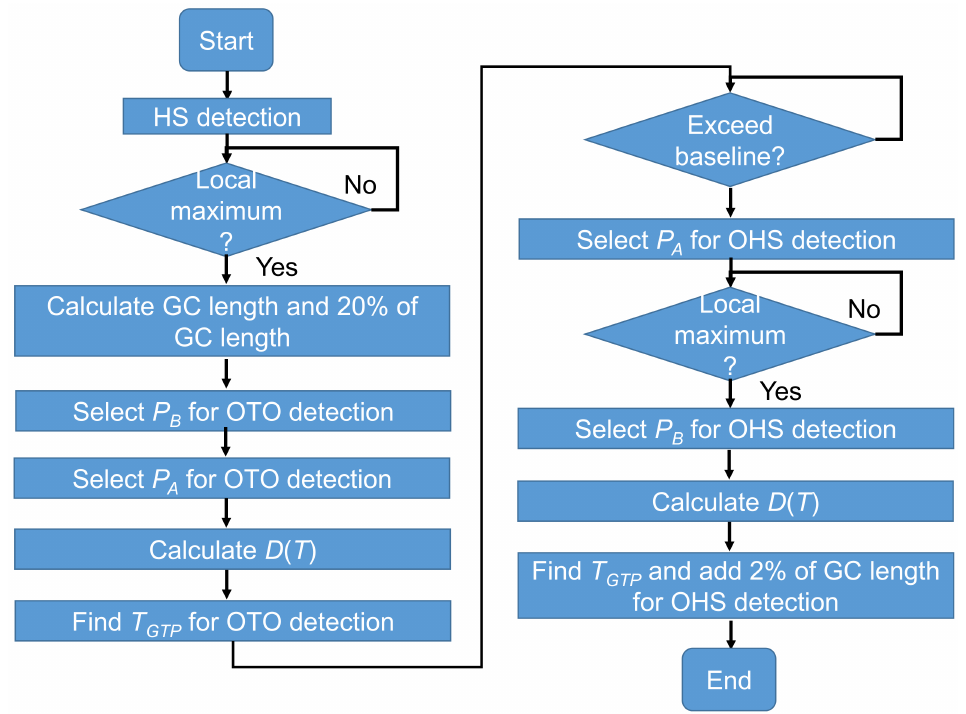
Figure 7. Algorithm for OHS and OTO detection in one GC from the IMS